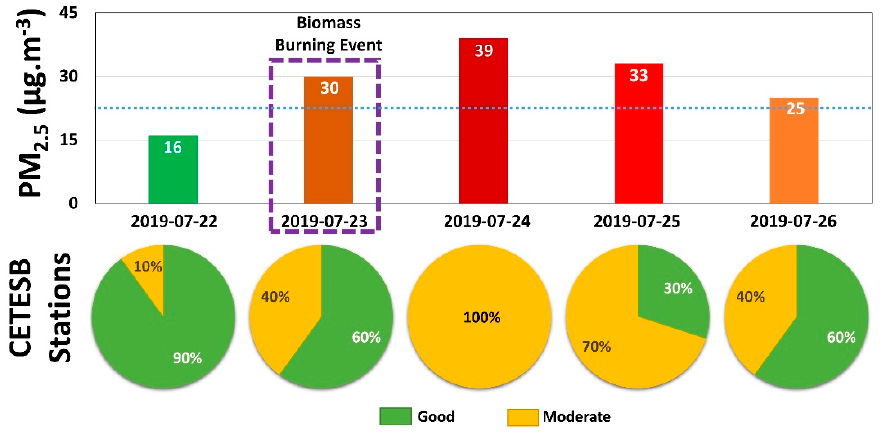
Figure 17. Average PM 2.5 daily values registered at Pinheiros Environment Company of São Paulo State (CETESB) station (upper) and air quality index in CETESB stations in MASP (lower).